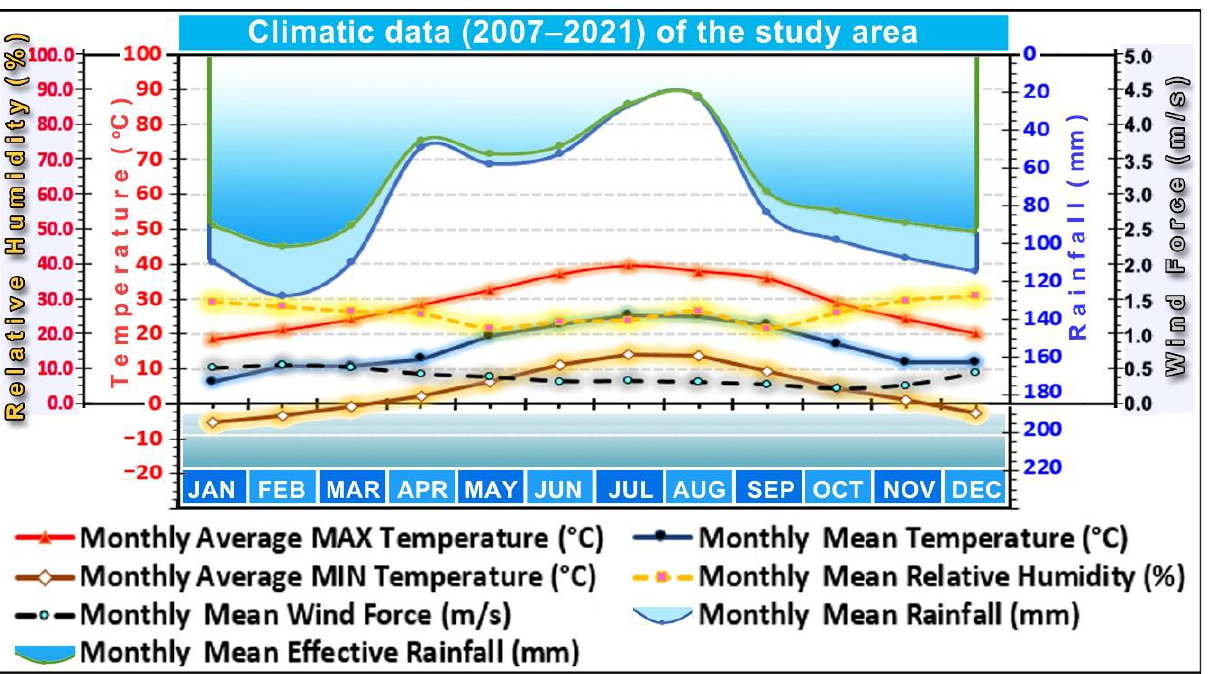
Figure 2. Various climatic data for the recent 15 years (2007 – 2021) of the study area.